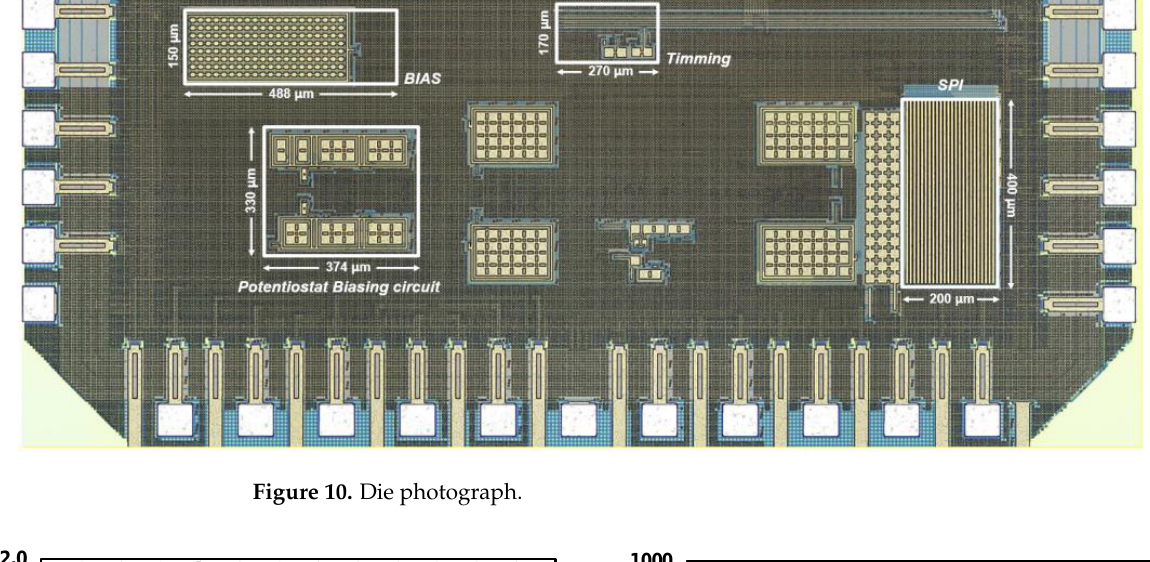
Figure 9. Differential output voltage change of potentiostat circuit according to feedback resistance: ( a ) Rf = 100 k Ω ; ( b ) Rf = 200 k Ω .